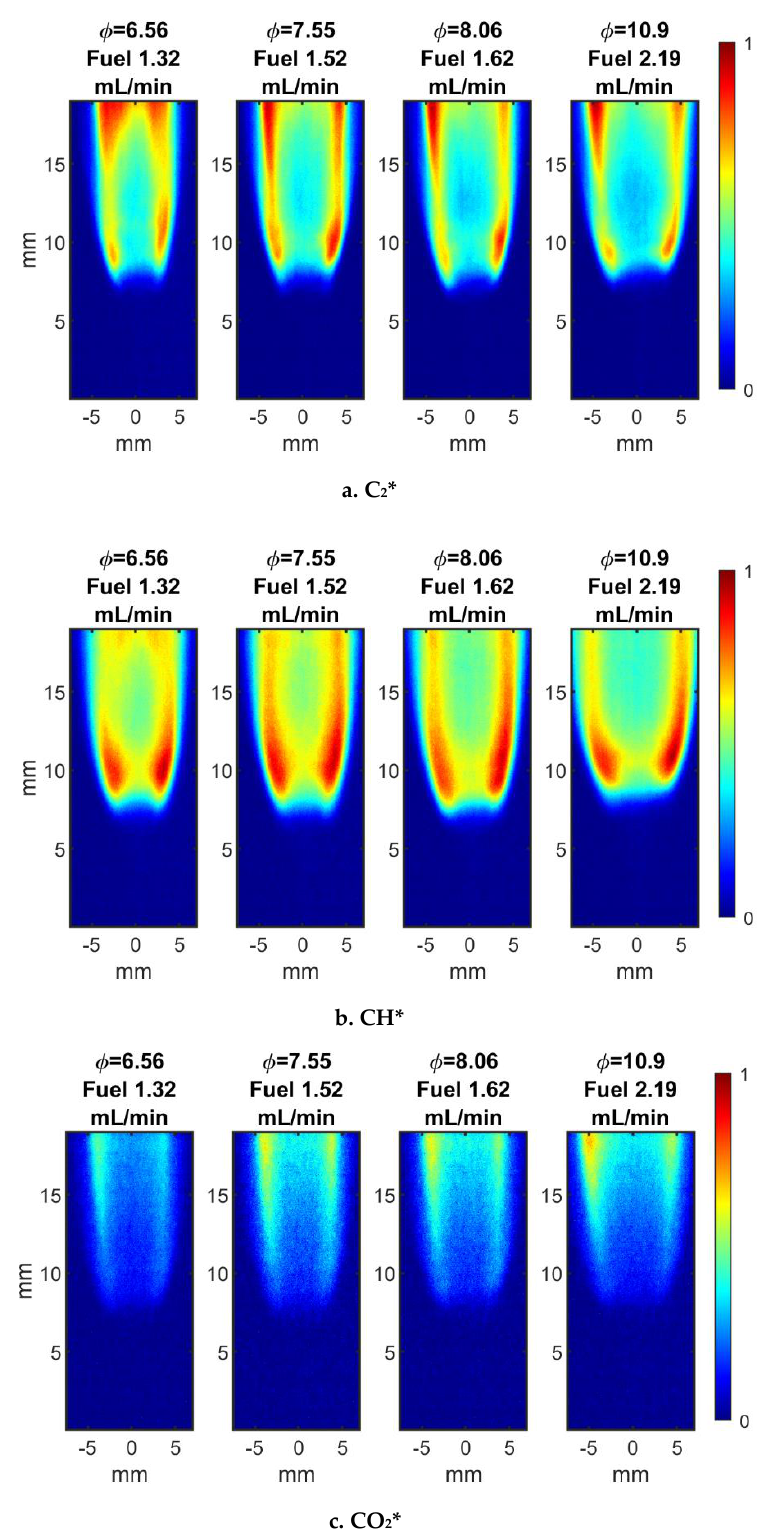
Figure 11. C 2 * ( a ), CH* ( b ), and CO 2 * ( c ) emissions for ignited Jet A sprays. The O 2 flow rate was fixed at 0.4 L/min.